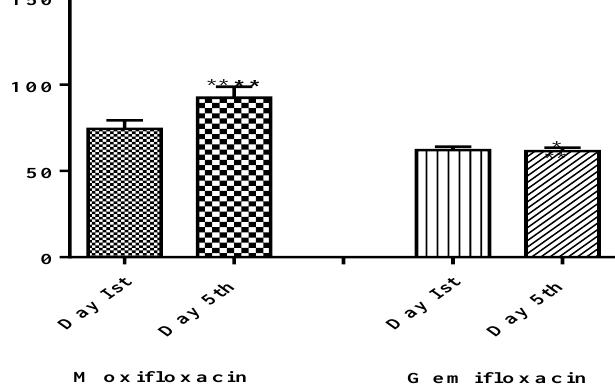
Figure 3. Comparison of QRS on baseline day one (Pre-dosing) and after dosing day five (Post-dosing) in both groups. Significant differences in QRS Complex in the moxifloxacin-treated group were noted, as compared to gemifloxacin. **** shows that p < 0.0001 which shows high level of significance by Moxifloxacin as compared to Gemifloxacin * p < 0.05. Table 2. Gender effect of moxifloxacin and gemifloxacin on QTc interval.